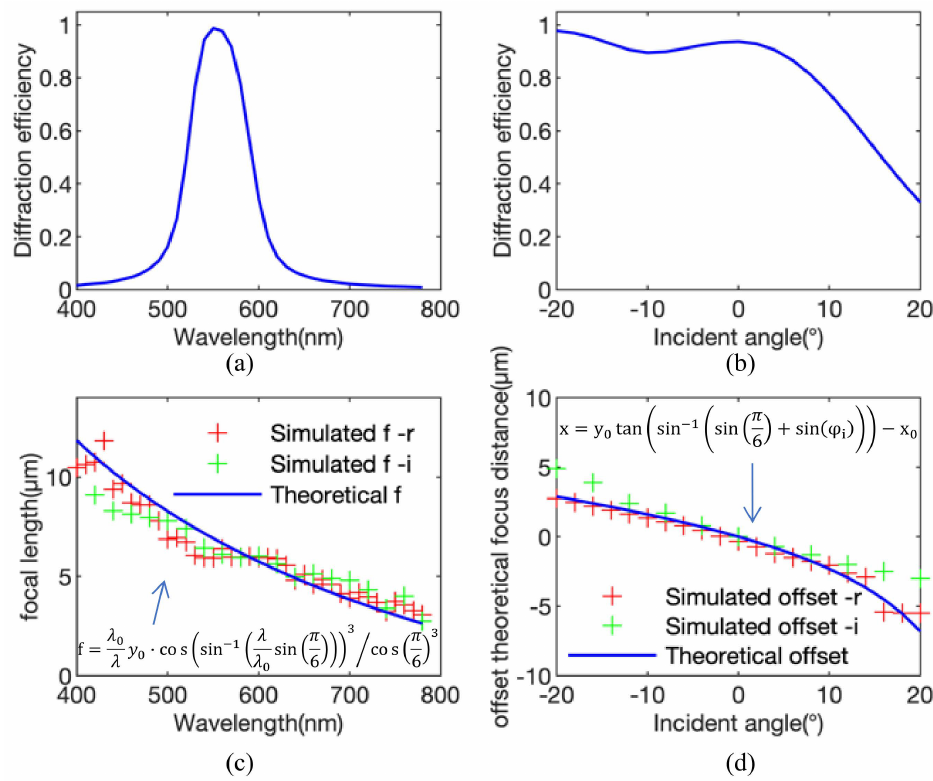
Figure 4. Diffraction properties of non-ideal PVL ( − r in the graphs) and diffraction properties compared with simulated ideal PVL ( − i in the graphs). ( a ) Diffraction efficiency and ( c ) focus position as a function of wavelength. ( b ) Diffraction efficiency and ( d ) focus position as a function of incident